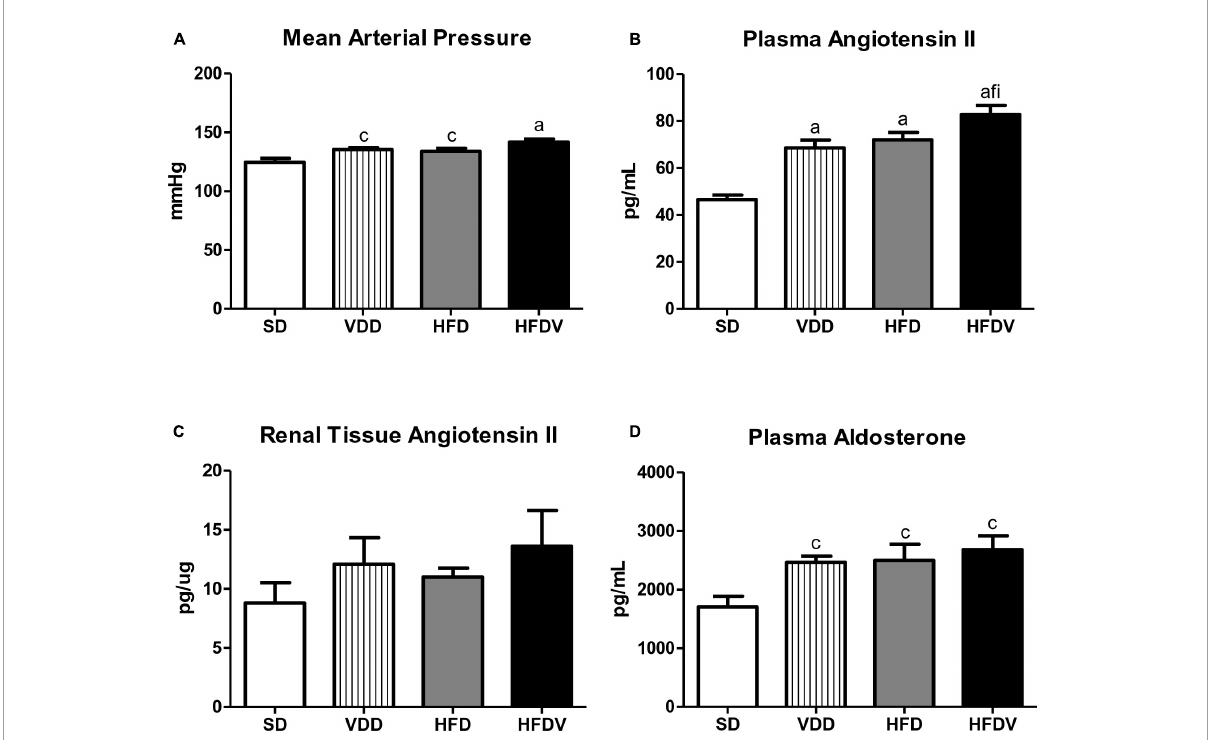
FIGURE3 (A) Mean arterial pressure (MAP), (B) plasma angiotensin II concentration, (C) quantitative amount of angiotensin II in renal tissue, and (D) plasma aldosterone concentration evaluated after the 90-day protocol in rats submitted to renal ischemia-reperfusion insult on day 45 treated